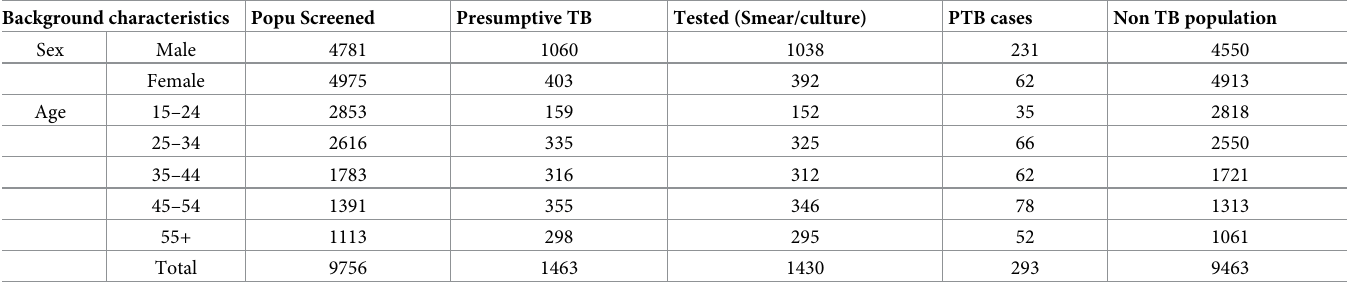
Table 1. Age-sex wise PTB cases (smear and/or culture positive) in the baseline survey. Background characteristics Popu